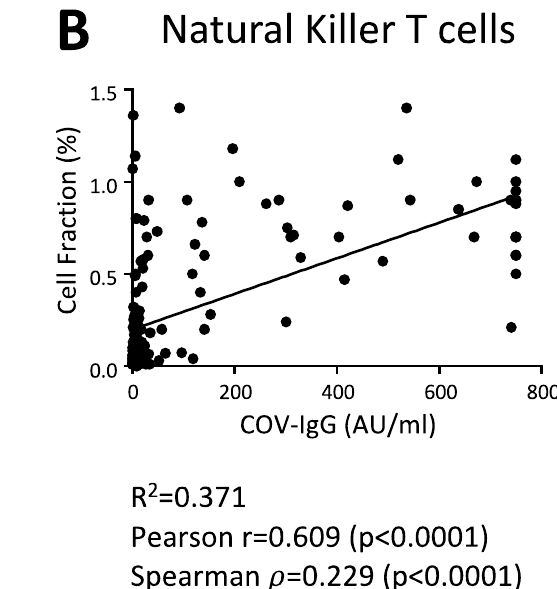
Figure 3. The levels of anti-SARS-CoV-2 IgG directly correlate with the S/RBD-binding B cells and total NK-T cells. Correlation analysis between the anti-SARS-CoV-2 IgG levels and the abundance of indicated cell populations, including B cells, interacting with the SARS-CoV-2 S RBD protein (S/GFP+ cells) ( A ) and total NK-T cells ( B ) in all vaccinated participants ( N = 160). Pearson correlation coefficient (r), Spearman’s rank correlation coefficient ( ρ ) and their statistical significance ( p -value) are reported in the graphs. Linear correlation was evaluated through the linear regression model. The linear regression line in black and R squared (R 2 ) are also shown in the graphs.